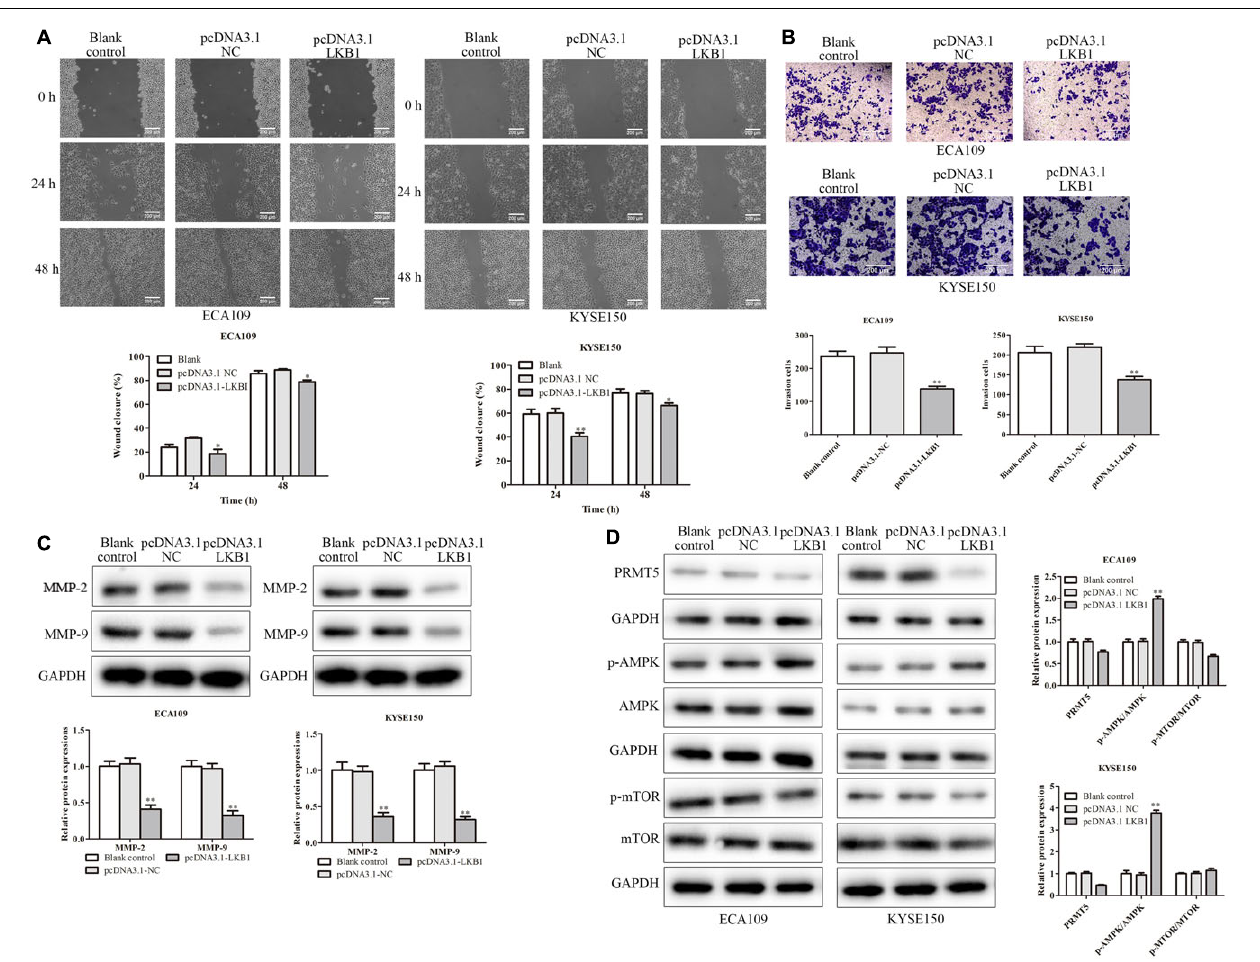
FIGURE 6 | LKB1 inhibited cell migration and invasion. (A) Wound-healing assay indicated that overexpression of LKB1 effectively inhibited cell mobility. The photographs were taken at the magnification of × 40. (B) Transwell invasion assay showed that overexpression of LKB1 decreased cell invasion abilities. The photographs were taken at the magnification of × 200. (D) The expressions of PRMT5, AMPK, p-AMPK, mTOR, and p-mTOR were analyzed in ECA109 and KYSE150 cells. (C) The expression levels of MMP-2 and MMP-9 were analyzed in ECA109 and KYSE150 cells. GAPDH was used as a control. Bars indicate the mean ± SEM, * P < 0.05, ** P < 0.01 vs. pcDNA3.0 NC. LKB1, liver kinase B1; PRMT5, protein arginine methyltransferase 5; AMPK, adenosine monophosphate kinase; mTOR, mammalian target of